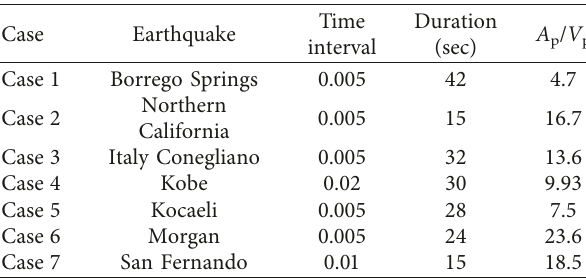
Figure 15: View from section 3-3 of the finite difference model of the Ilısu dam. Table 2: Properties of the far-fault